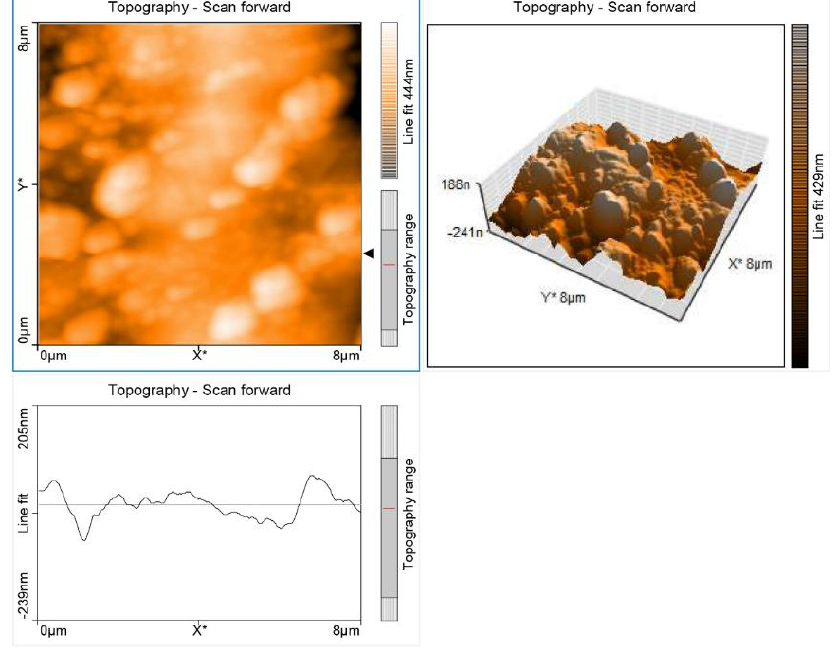
Figure 3. AFM analysis of the modified